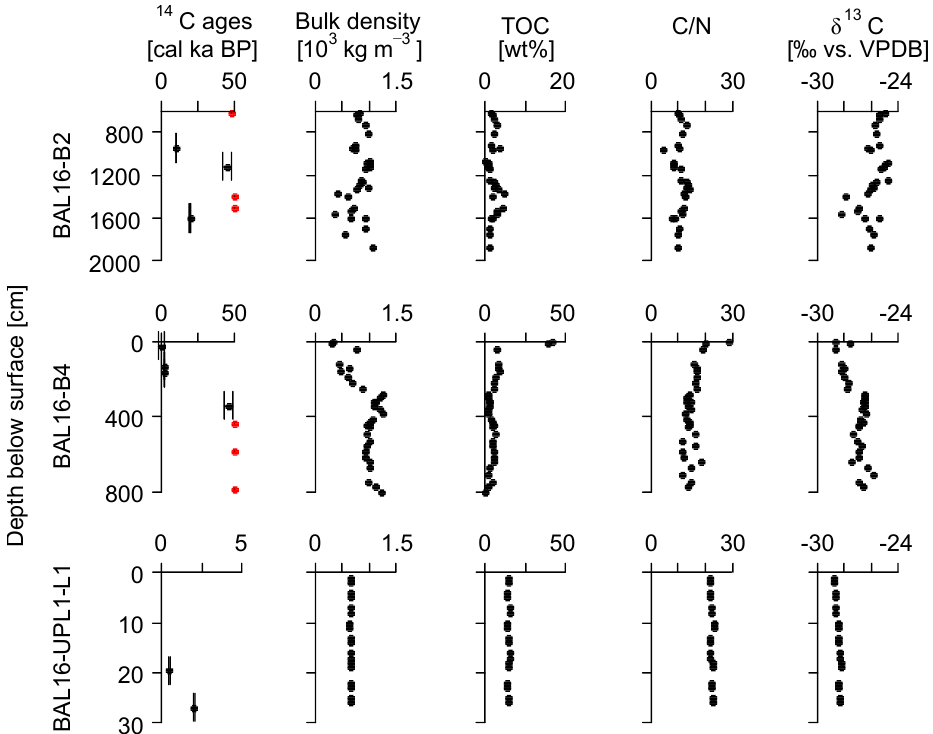
Figure 2. Summary of cryostratigraphical and biogeochemical parameters of BAL16-B2 (yedoma), BAL16-B4 (drained thermokarst lake basin) and BAL16-UPL1-L1 (thermokarst lake): calibrated radiocarbon ages ( 14 C; infinite ages in red), bulk density, total organic carbon (TOC), total organic carbon to total nitrogen ratio (C / N), stable carbon isotopes ( δ 13 C). Note: different x axes for 14 C and TOC. Table 2. Radiocarbon dates of BAL16-B2 (yedoma), BAL16-B4 (drained thermokarst lake basin) and BAL16-UPL1-L1 (thermokarst lake). Calibrations were performed using CALIB 7.1 software and the IntCal13 calibration curve (Stuiver et al., 2017). Symbol ± for standard deviation; Poz: Pozna´n Radiocarbon Laboratory, Poland; pMC: percent modern